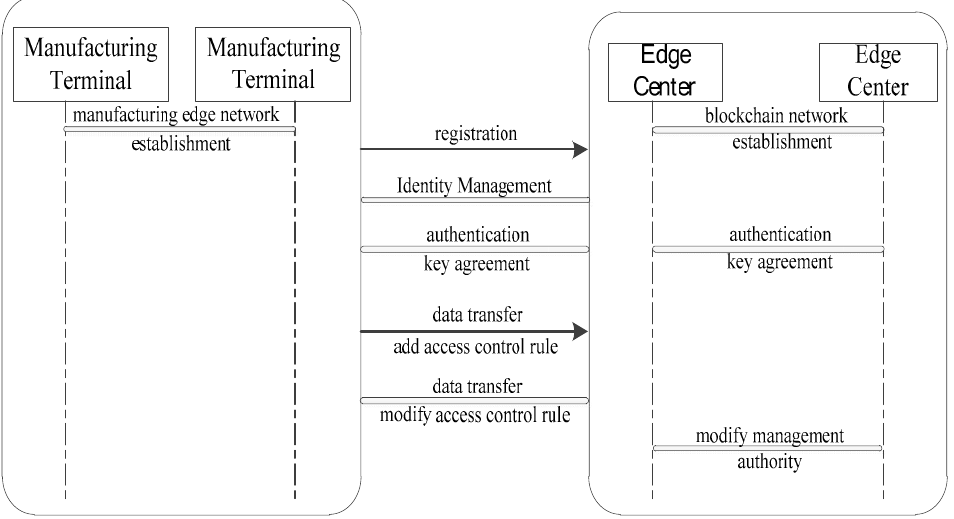
Figure 4. Setup and operation of access control with identity management.